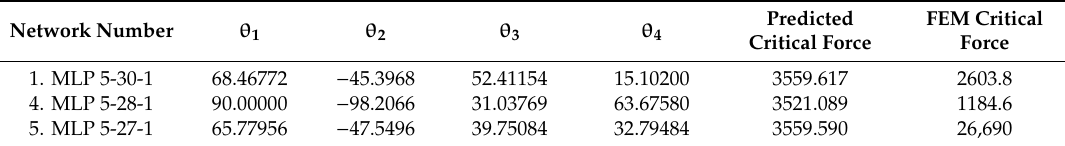
Table 7. The values of the optimum angle configurations determined for each neural network as well as the values of the predicted critical forces and obtained using